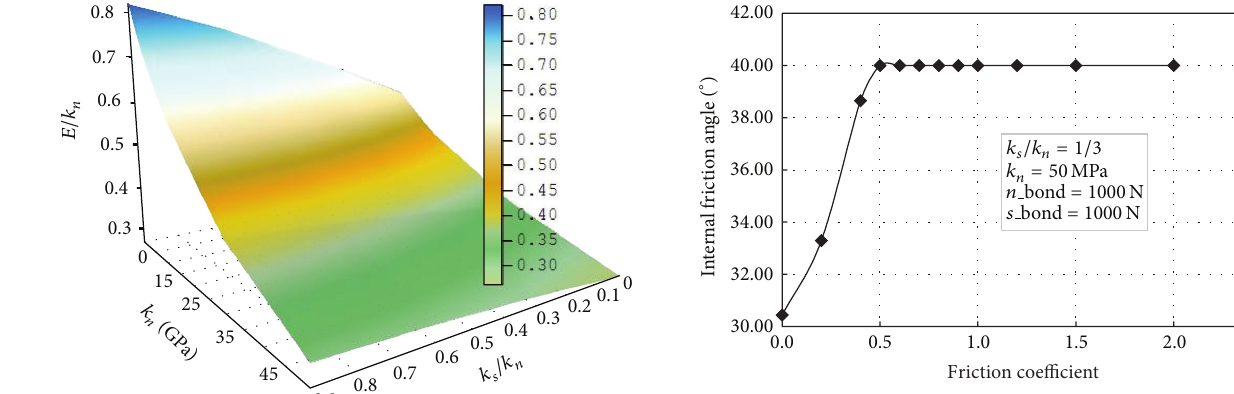
Figure 8: The changes in Young’s modulus with the microdeforma- tion parameters.